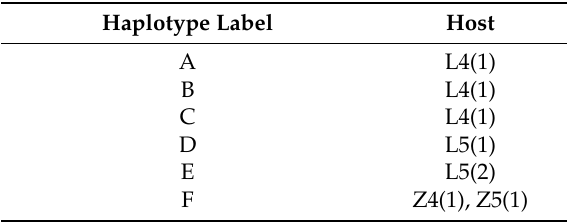
Table 4. List of the haplotypes identified in the “single trophozoites” approach, with respective label, host and frequency within the same insect